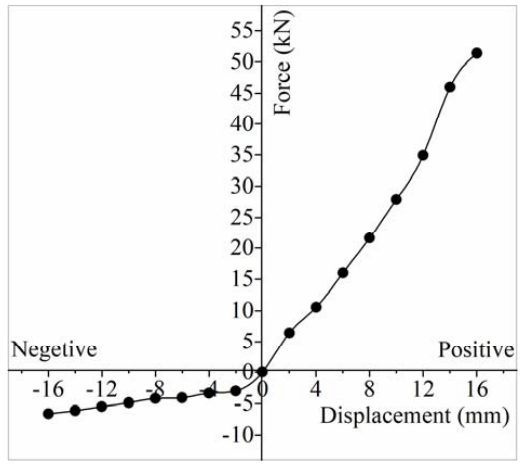
Figure 17. Skeleton curve for the test specimen.